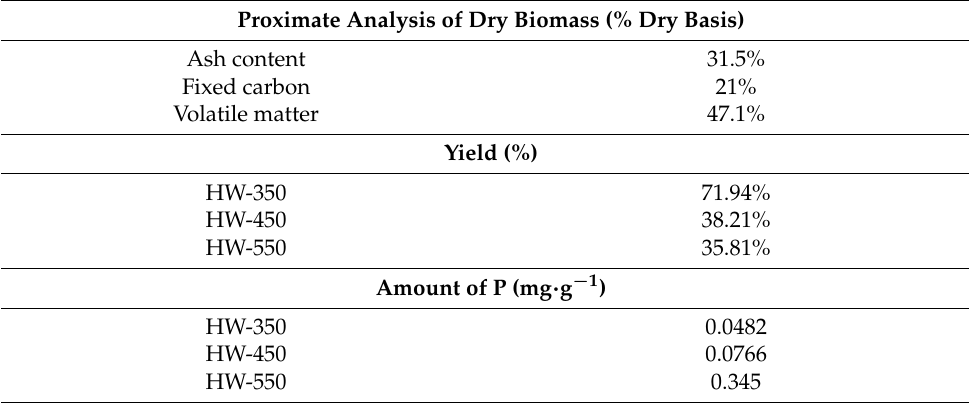
Table 3. Proximate composition of biochar at different